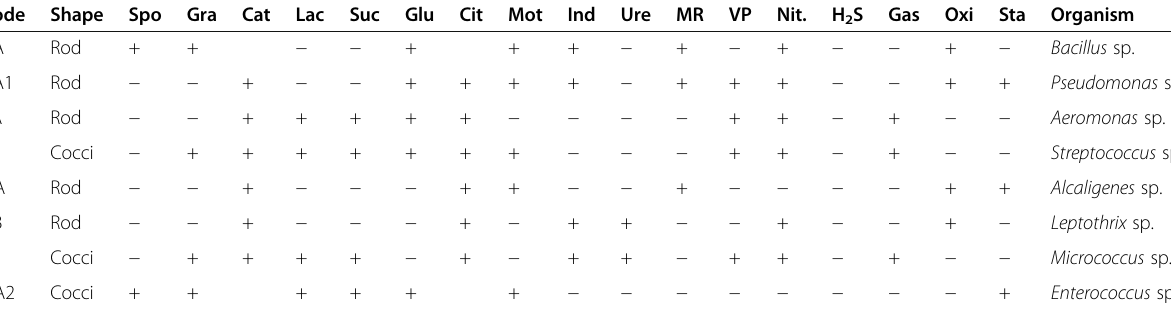
Table 4 Morphological and biochemical characteristics of bacterial isolates from soil of mining areas in Zamfara State Code